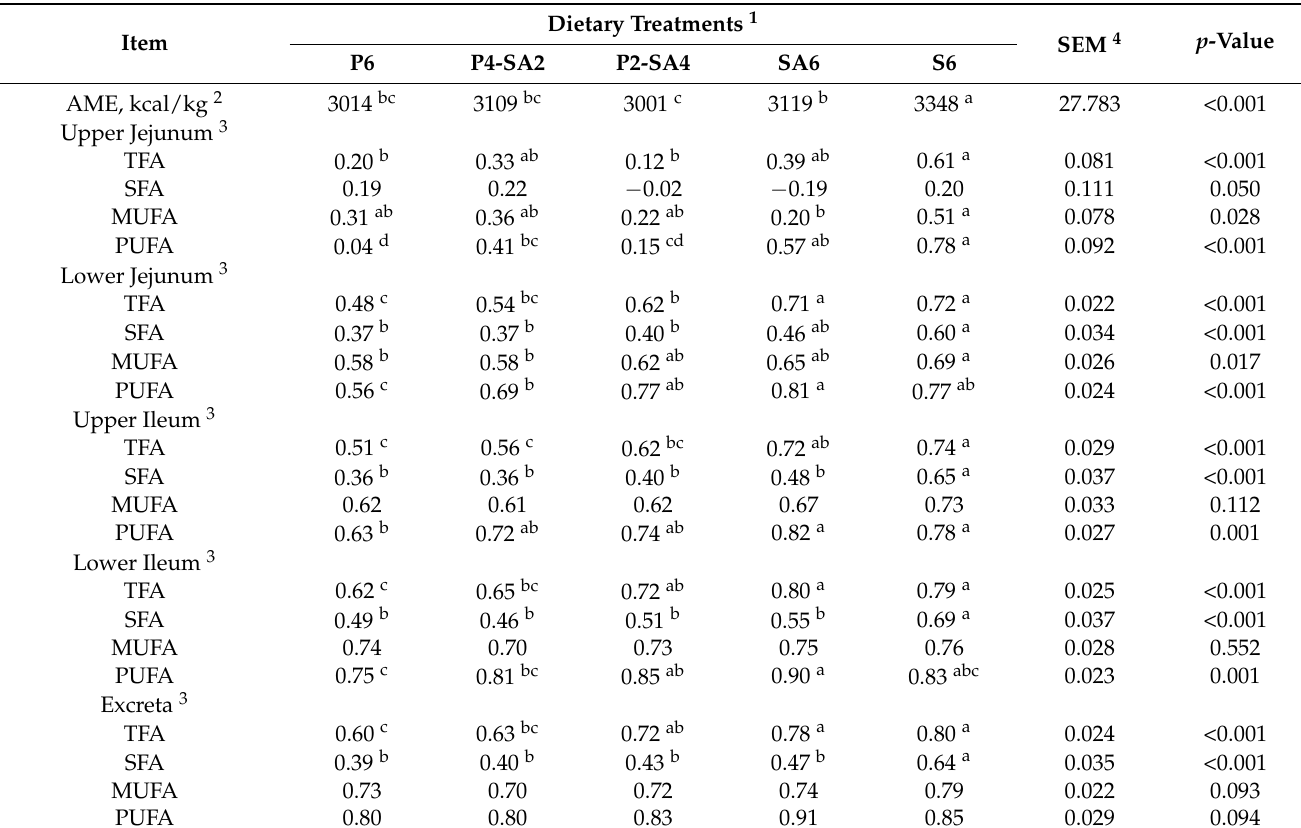
Table 7. Apparent metabolizable energy values and apparent fatty-acid digestibility coefficients in the different intestinal segments and total tract digestibility according to various fat sources in the diet in 11-d-old broiler